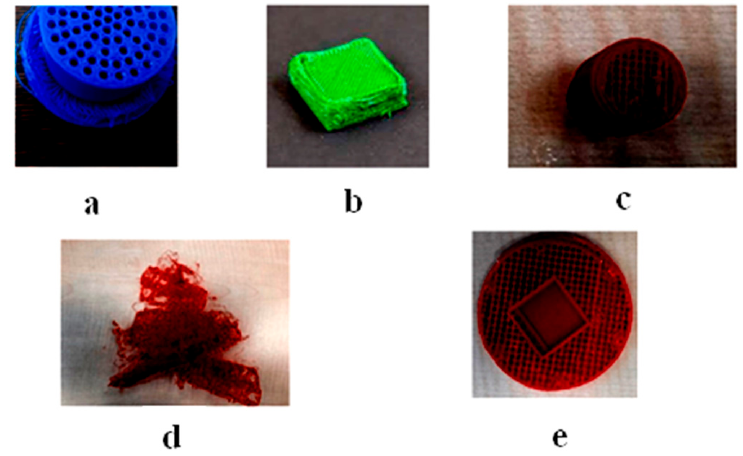
Figure 5. Common errors in 3D printing ( a ) Stringing ( b ) Over-extrusion ( c ) Under-extrusion ( d ) Pillowing ( e ) Layer Shifting.